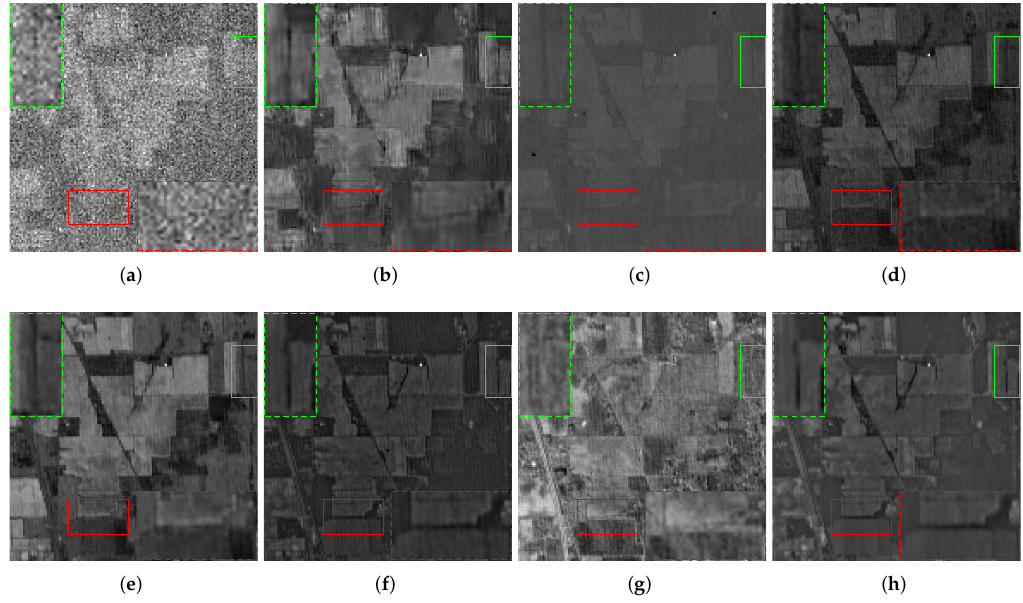
Figure 12. Restored results of band 220 by different algorithms in Indian Pines dataset. ( a ) The